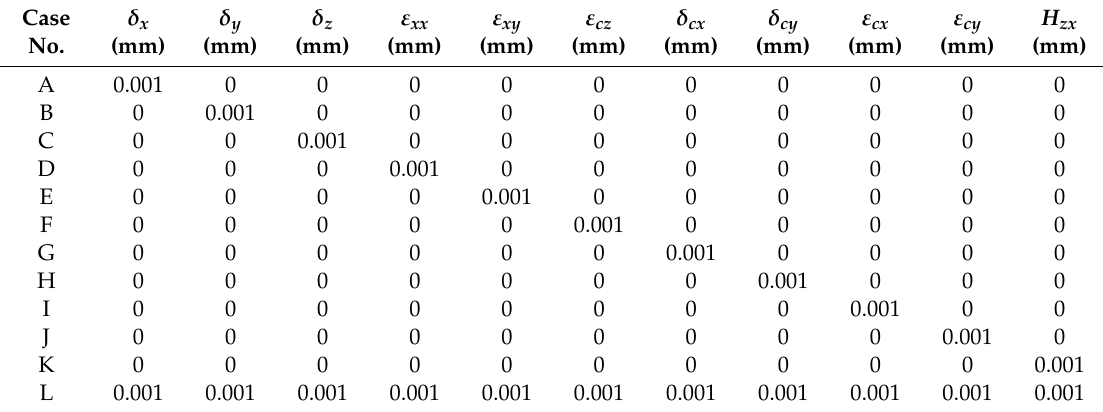
Table 3. Simulation plans and error values.